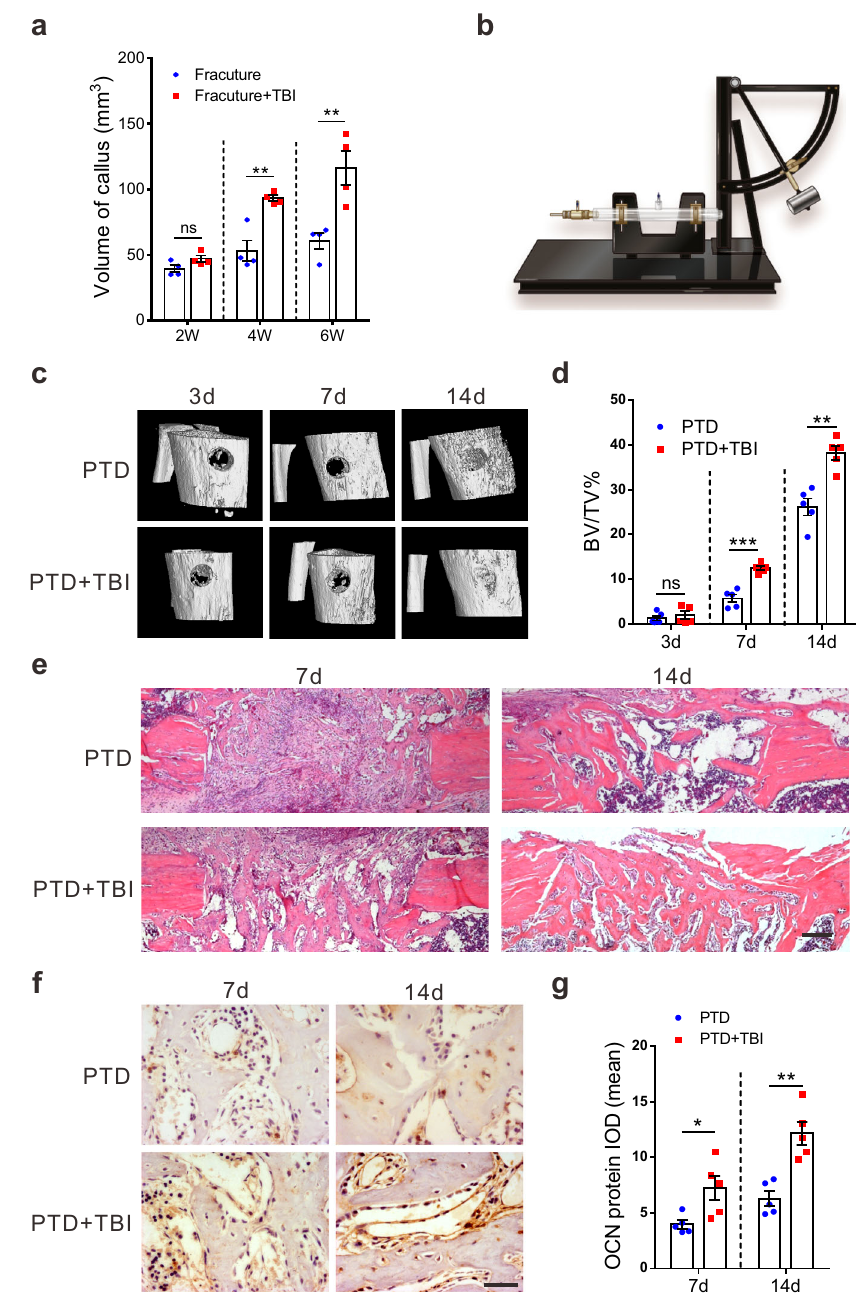
Fig. 1 TBI (traumatic brain injury) accelerates bone healing in patients and rats. a Fracture callus volume in fracture alone patients and TBI patients with concomitant fracture ( n = 4 person per group per time point, Student ’ s two-sided unpaired t test). P (2w TBI + fracture vs. 2w Fracture) = 0.0787, P (4w TBI + fracture vs. = 0.0028, P = 0.0082. b Scheme illustrating the fl uid-percussion device for experimentally induced TBI. (6w TBI + fracture vs. 6w Fracture) 4w Fracture) Representative micro-computed tomography (CT) 3D image ( c ) and BV/TV% analysis ( d ) of defect sites of PTD (proximal tibia defect) and PTD + TBI (PTD combined-TBI) groups on day 3, 7, and 14 after operation ( n = 5 animals per group per time point; Student ’ s two-sided unpaired t test). P (3d PTD + TBI vs. PTD) = 0.5424, P (7d PTD + TBI vs. PTD) = 0.0001, P (14d PTD + TBI vs. PTD) = 0.0011. e Representative H&E staining of rat PTD sites show newly formed woven bone in the defect sites. Scale bars, 200 µ m ( n = 5 animals per group per time point). f , g Representative immunohistochemical staining and quantitation of OCN-positive cells in rat PTD sites at 7 and 14 days after surgery ( n = 5; Student ’ s two-sided unpaired t test). P (7d PTD + TBI vs. PTD) = 0.0225, P = 0.0014. Scale bars, 40 µ m. The quantitation result were plotted as dot plots, showing the mean ± SEM of three independent (14d PTD + TBI vs. PTD) experiments. * P < 0.05, ** P < 0.01; ns = nonsigni fi